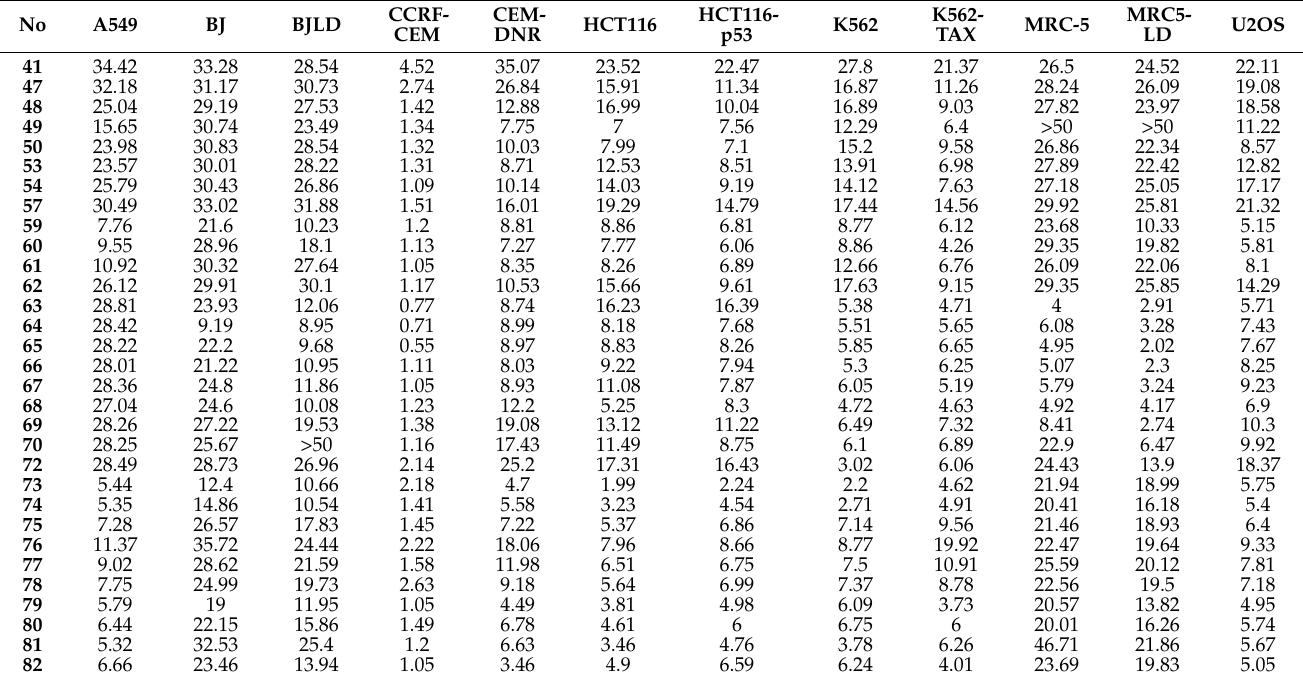
Table 3. Cytotoxic activity (IC 50 , µ M) of 7-chloro-(4-thioalkylquinoline) derivatives 41 – 82 after 72 h of incubation with cancerous and noncancerous human cell